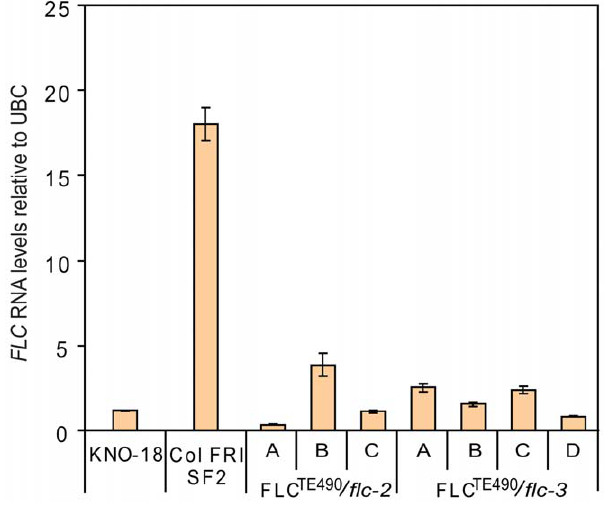
Figure 5. FLC expression level of Col FRIflc lines containing FLC TE490 compared to controls. FLC RNA levels measured by qRT-PCR and normalised to UBC . Error bars show standard error from three experimental